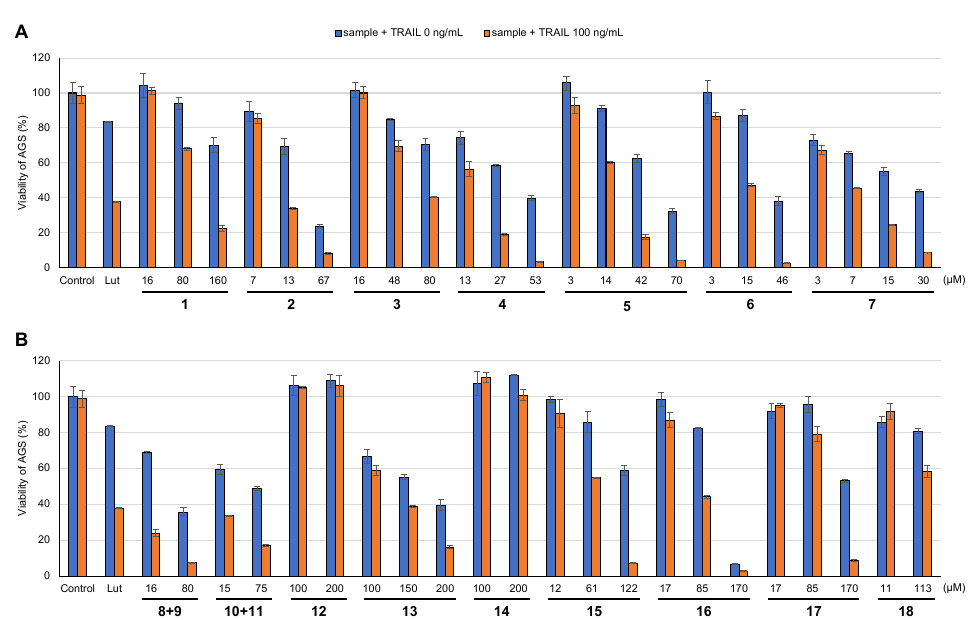
Figure 2. TRAIL resistance-overcoming activity. ( A ) compounds 1 – 7 , ( B ) compounds 8 - 18 . Data are presented as the mean ± SD ( n = 3). Lut, luteolin; SD, standard deviation. Luteolin (17.5 μ M) was used as a positive control.